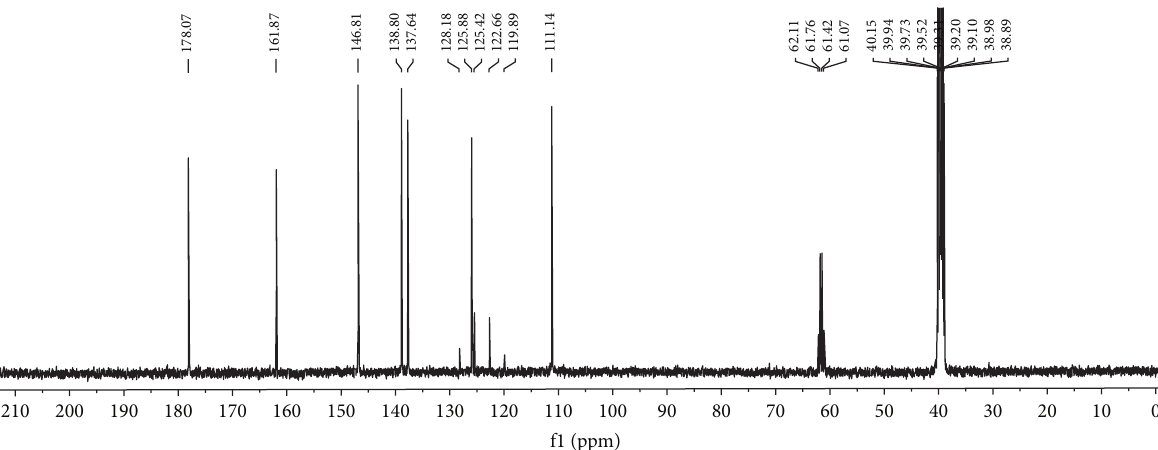
Figure 2: 13 C{ 1 H}NMR spectrum of compound 1 .